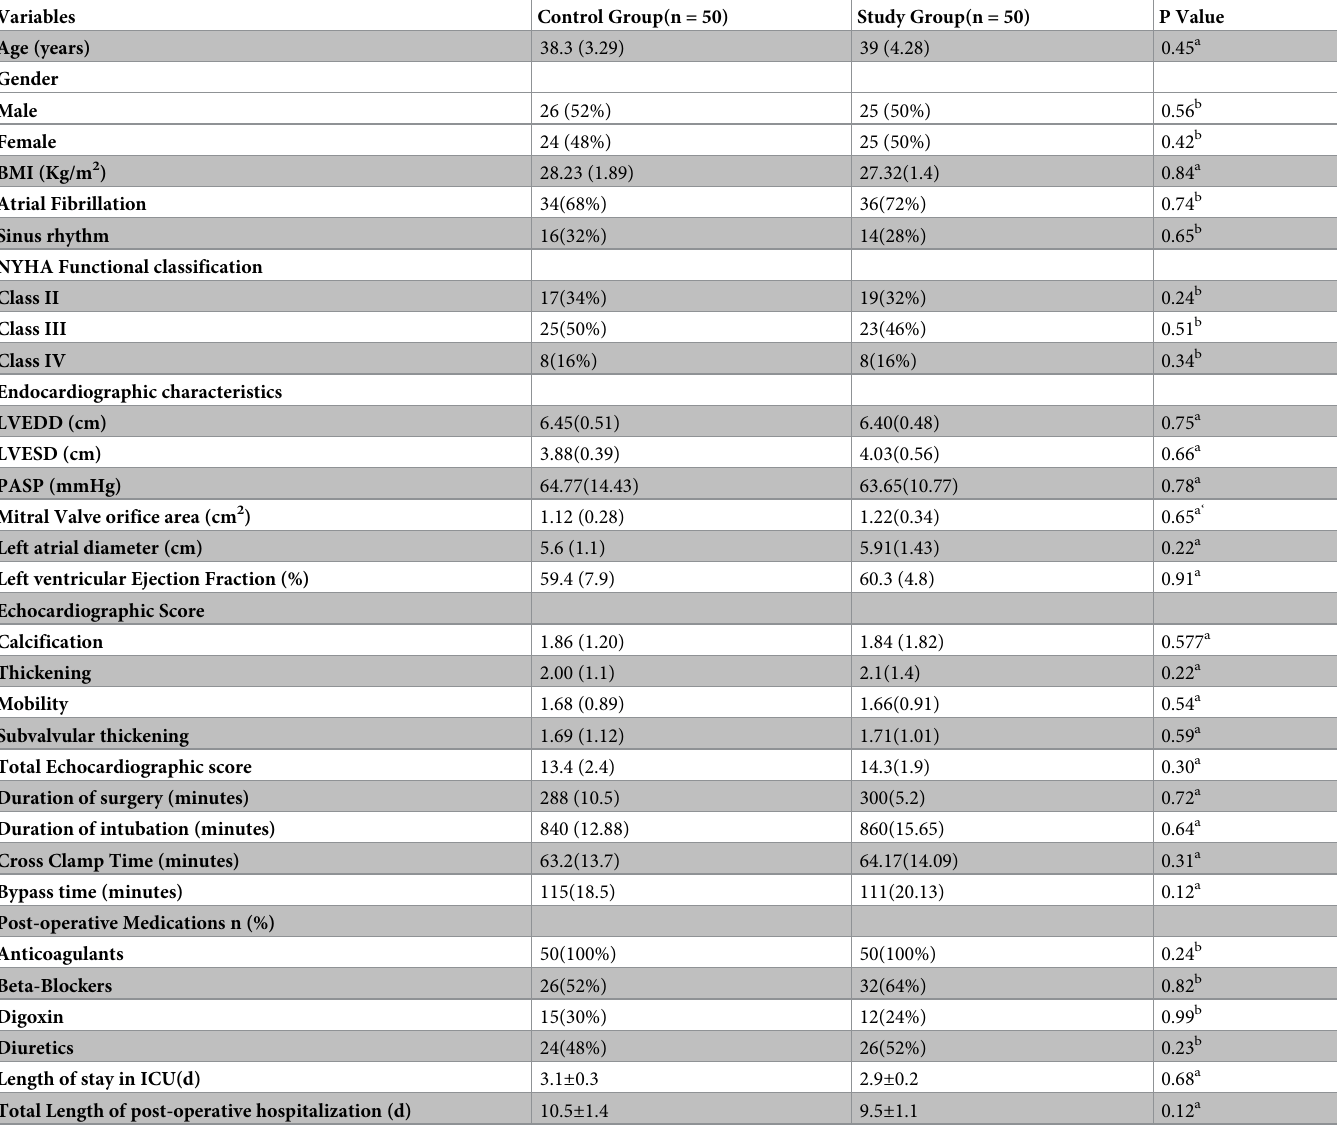
Table 1. Baseline demographic, clinical and operative characteristics of the participants in both study and control groups.